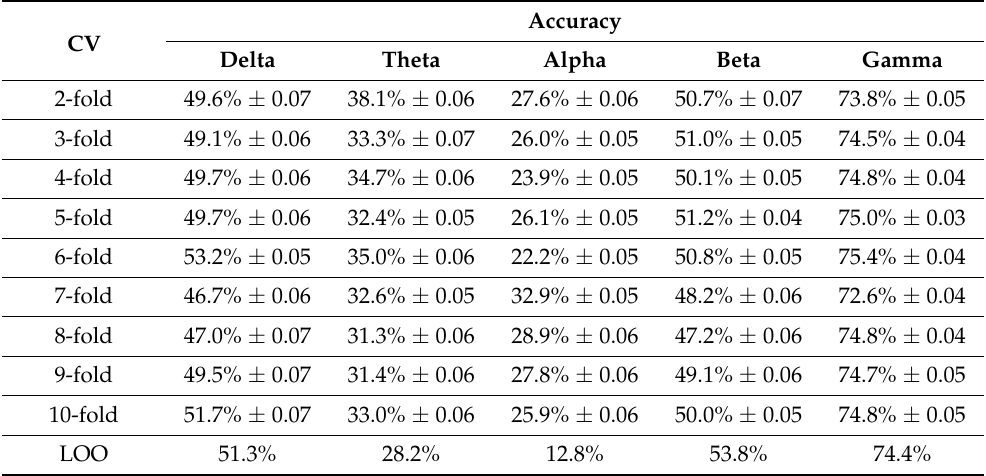
Table 3. Accuracies of the SVM-ML model for classifying the three upper-limb groups with different k-fold CV strategies in the different frequency bands.